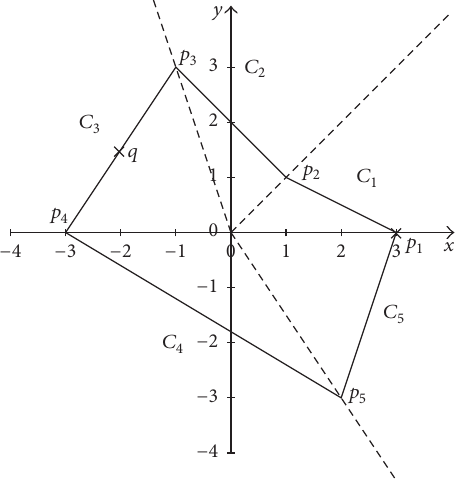
Figure 12: Pentagon P and the convex polyhedral fan C for P in Example